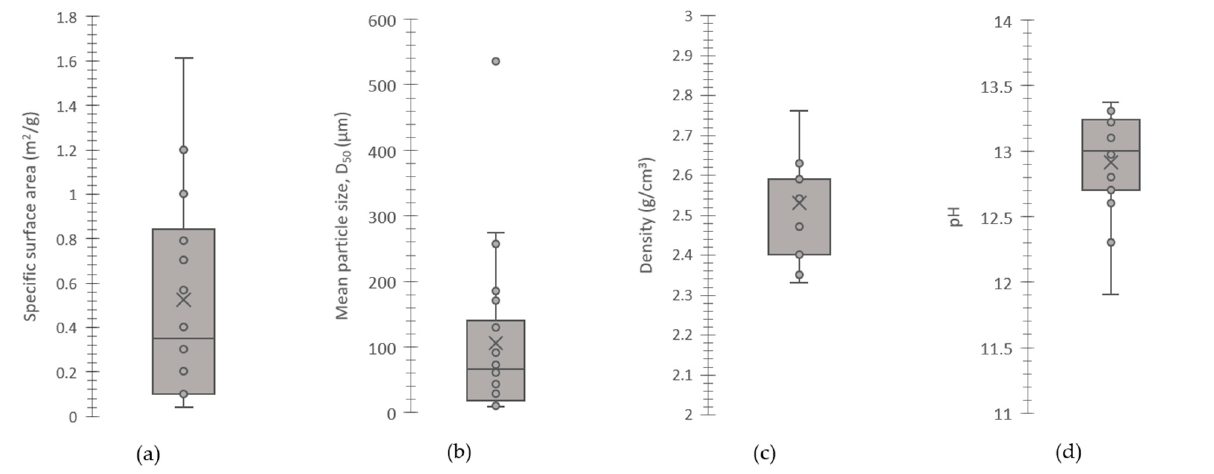
Figure 3. ( a ) The speci fi c surface area [21,39,40], ( b ) mean particle size [21,24,39,41,42], ( c ) density [17,24,30,42], and ( d ) pH [21,42] values of various wood ashes reported in the